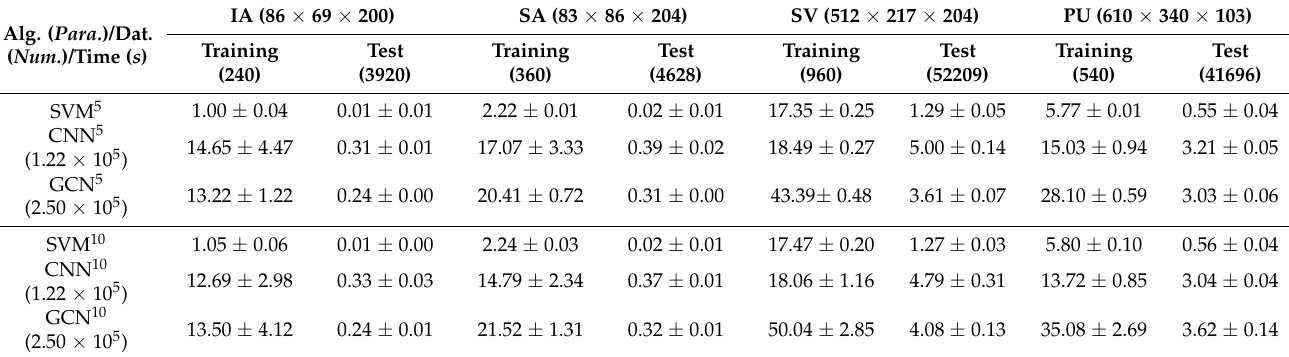
Table 3. Total network parameters and time consumption (i.e., the average time of 5 and 10 random runs). Note that the numbers in parentheses regarding datasets and models indicate the number of samples and the number of network parameters,